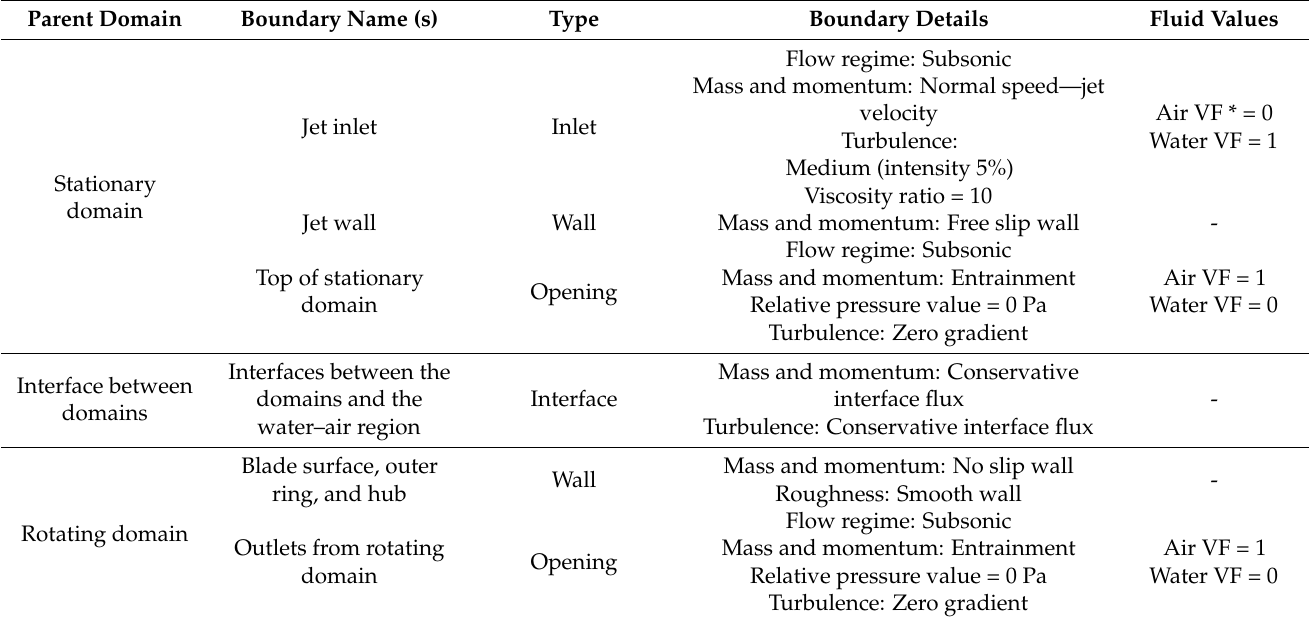
Table 2. Boundary conditions of the CFD model.